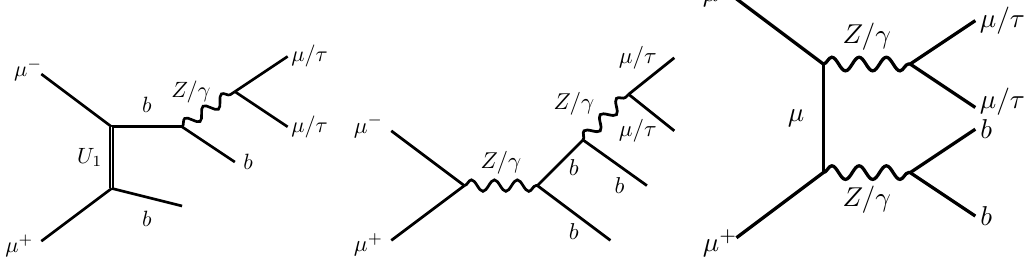
Figure 2 . An example “barking dog” diagram with one intermediate LQ leading to the same final states as in figure 1 (left), as well as representative diagrams leading to the same final state as the PP signal in the SM (center and right). The distinct topologies of SM and LQ contribution to these final states gives rise to different kinematic observables that we can cut